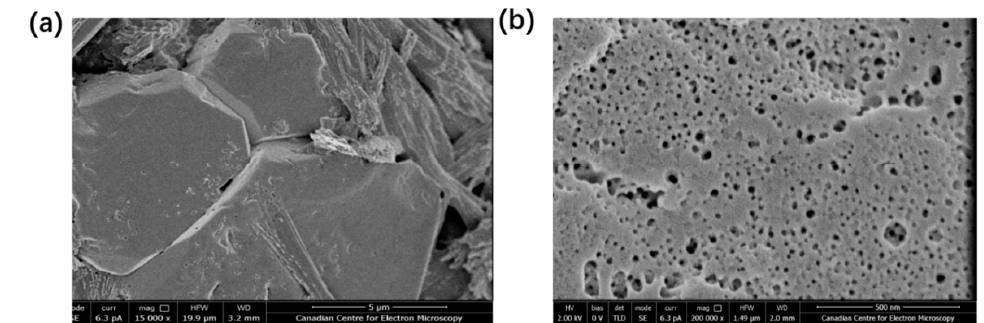
Figure 3. Schematic illustration of EAPbI 3 formation process.